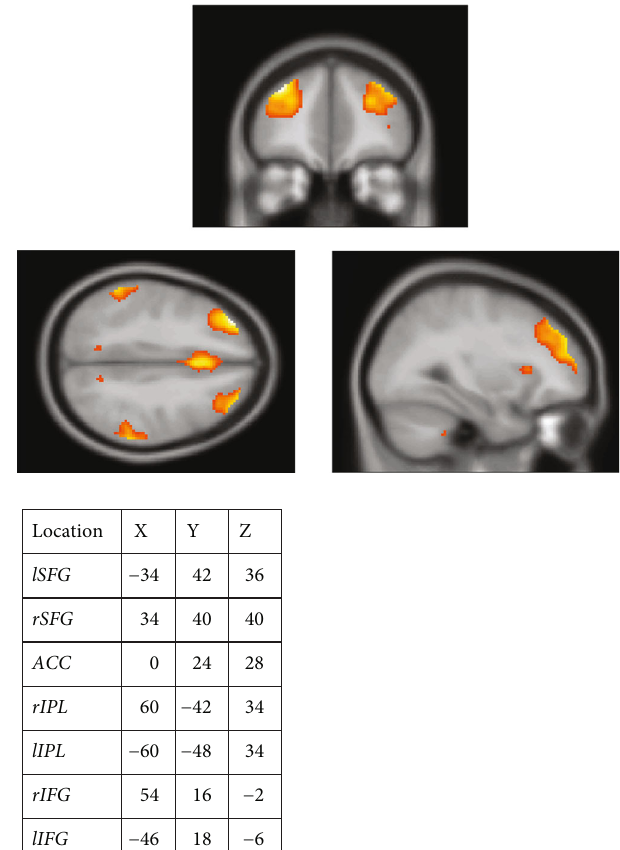
Figure 7. The correlation between tDCS-induced behavioral and connectivity changes in the real stimulation condition was not signi fi cant ( r ð 20 Þ = − 0 : 253 , p = 0 : 282 ).